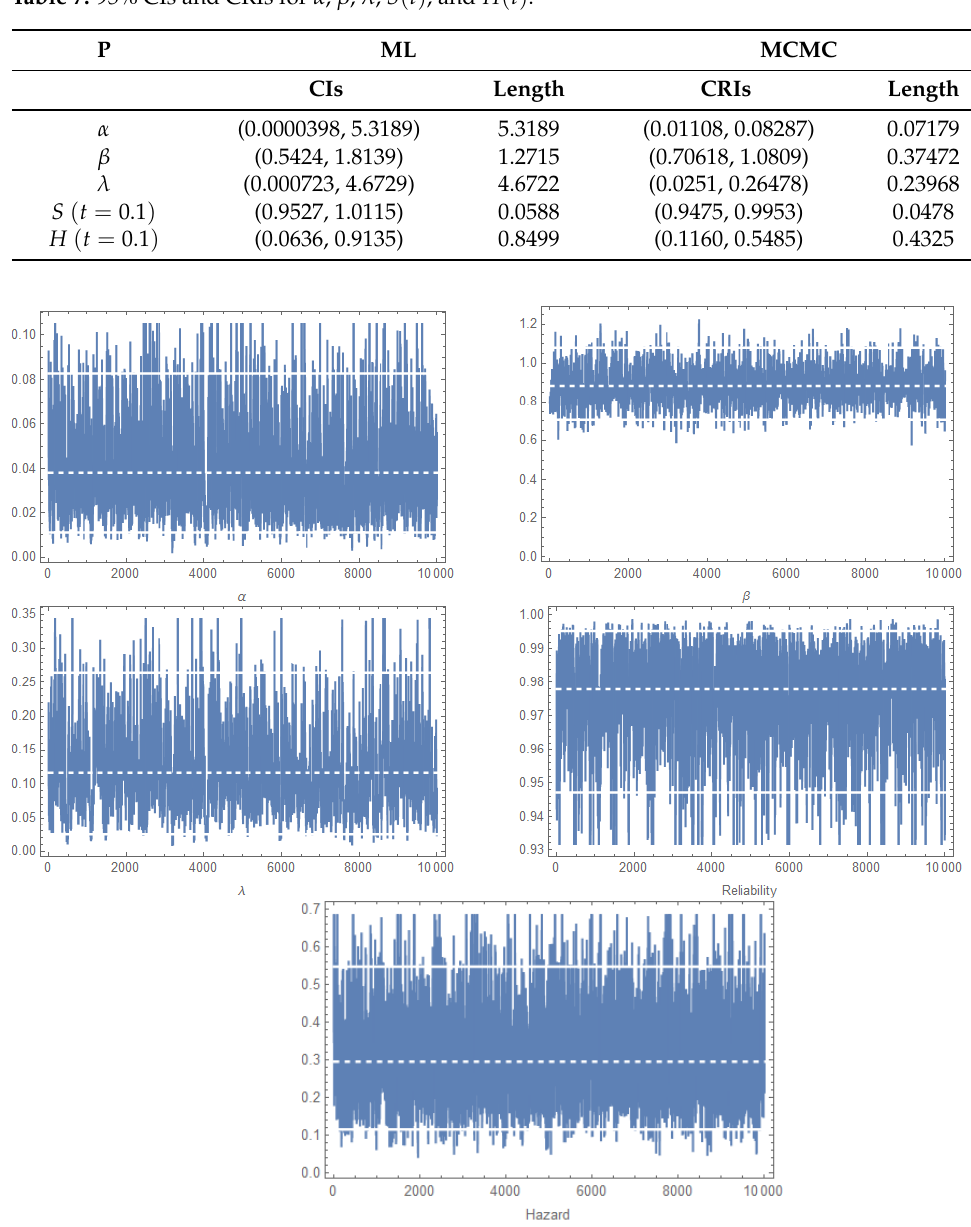
Table 7. 95% CIs and CRIs for α , β , λ , S ( t ) , and H ( t ) .